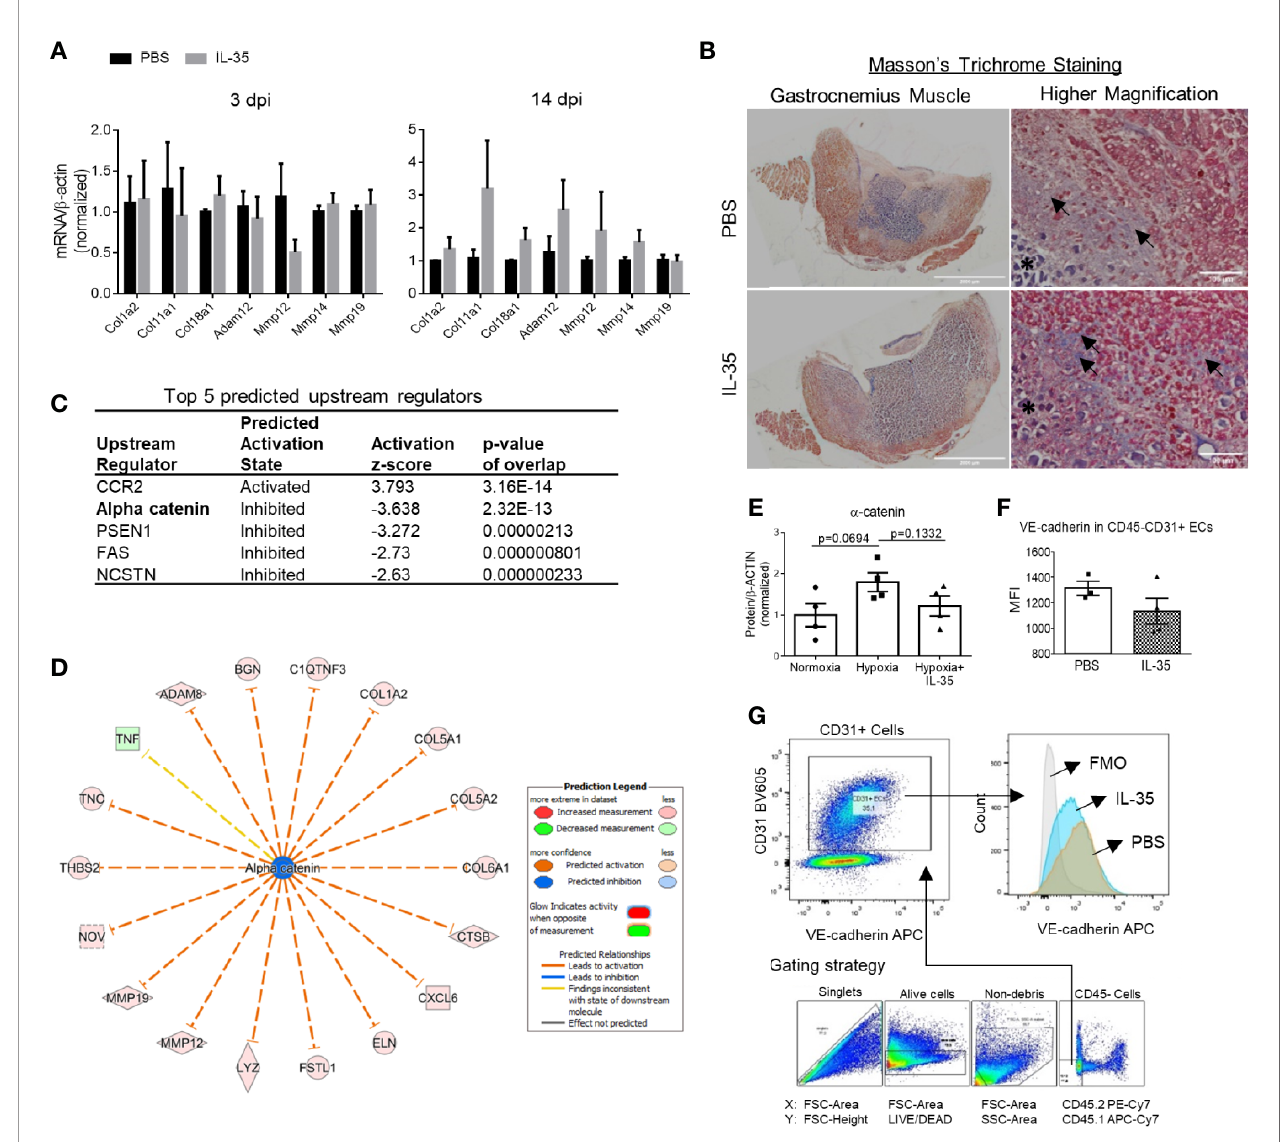
FIGURE 5 | IL-35 induces extracellular matrix genes in vivo , possibly via impairing the core complex in endothelial cell adhesion junction, (VE-cadherin) – plakoglobin – ( a -catenin). (A) Con fi rmation of RNA-Seq results by qRT-PCR. Representative genes included collagens and matrix metalloproteinases, which were signi fi cantly upregulated in RNA-Seq data. After IL-35 or PBS injection following HLI for 3 or 14 days (same as Figure 3A ), RNA was extracted from the ischemic muscle. n ≥ 3. (B) Representative images of Masson ’ s trichrome staining of gastrocnemius (GC) muscle (left panel) and higher magni fi cation (right panel) of non-necrotic areas (black arrows) showing the collagen deposition. The stars indicated necrotic tissues with dark purple staining. (C) The top fi ve upstream regulators predicted to be signi fi cantly activated or inhibited using IPA core analysis. (D) The network of a -catenin regulating 18 downstream molecules that were signi fi cantly changed in IL-35- treated ECs in the ischemic muscle at 14 days post-ischemia (dpi). (E) Statistics of a -catenin protein level in human microvascular endothelial cells (HMVECs). (F) . The gating strategy of mouse EC from ischemic muscle. Digested muscle cells were fi rst gated for singlet with forward scatter (FSC)-Area and FSC-Height, alive cells with FSC-Area and LIVE/DEAD (stains only dead cells), non-debris with FSC-Area and side scatter (SSC)-Area, and then CD45 − cells with antibodies of CD45.2 PE-Cy7 and CD45.1 APC-Cy7. (C) Density plot with antibodies of CD31 BV605 and VE-cadherin APC. CD31+ ECs were gated from the CD45- cell population. (G) Statistics of VE-cadherin median fl uorescent intensity (MFI) in IL-35 or PBS-injected groups. All animal results were collected from male mice. Scale bar sized are as indicated in the pictures. Data are presented as mean ±